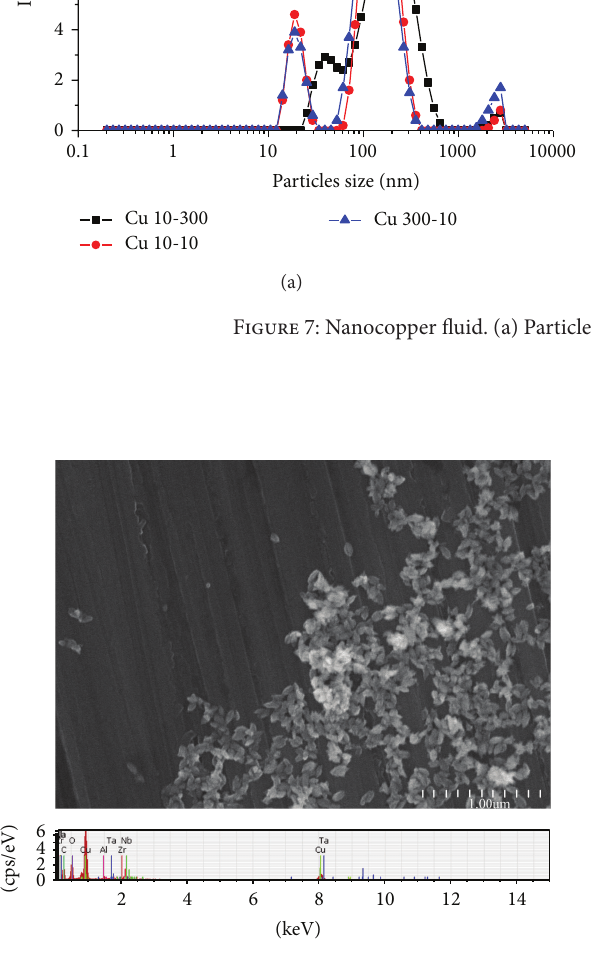
Figure 8: Nanocopper, SEM (SEM-EDX).